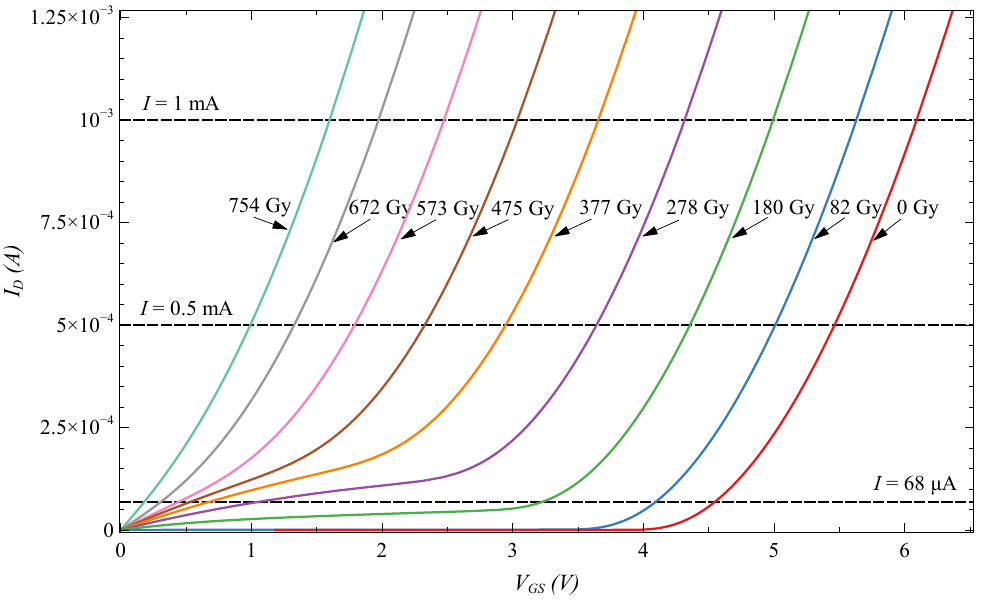
Figure 12. Degradation of transfer characteristic of EPAD with 10 V bias during